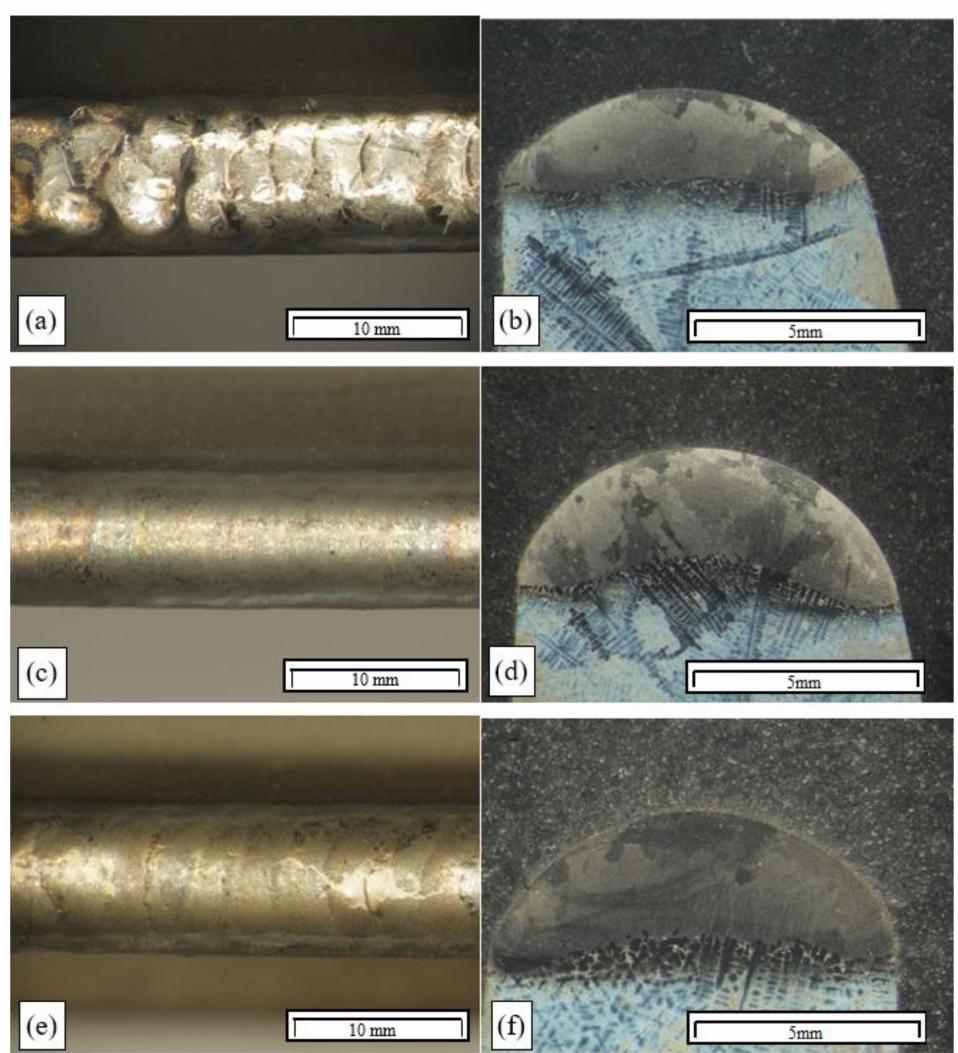
Figure 12. Surfaces and macrostructures of a remelted area and two padding welds made by TIG in a TecLine 8910 atmosphere: ( a , b ) remelting of the base material with no filler, arc linear energy: 0.15 kJ/mm; ( c , d ) padding weld, arc linear energy: 0.31 kJ/mm; ( e , f ) padding weld made with Thermanit 625 wire, arc linear energy: 0.35 kJ/mm.